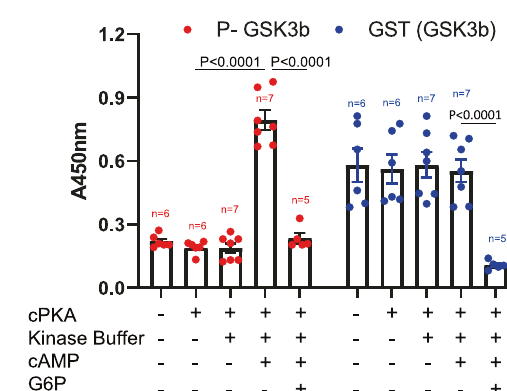
Fig. 4 HK2-GSK3 β -R1a tertiary complex binds PKA catalytic subunit and promotes GSK3 β phosphorylation. a Nickel-coated plates were incubated overnight at 4 °C with His-HK2 (50 nM) and then successively incubated with Myc-PRKAR1 α (32 nM), PKAc (20 nM), and GST-GSK3 β (32 nM). For the negative control experiments, His-HK2 or Myc-PRKAR1 α were omitted. Once all proteins are bound, antibodies against HK2, PRKAR1 α , PKAc, or GSK3 β are added for overnight incubation and detection is carried out after incubation with HRP-conjugated anti-rabbit or mouse IgG as described in Methods. Results are the mean ± SEM of four independent experiments. b Nickel-coated plates were incubated overnight at 4 °C with His-HK2 (50 nM) and then successively incubated with Myc-PRKAR1 α (32 nM), PKAc (20 nM) and GST-GSK3 β (32 nM). Kinase buffer in the presence or absence of cAMP is added to appropriate wells and P-GSK3 β antibody is added overnight, and then detected by incubation with HRP-conjugated anti-rabbit IgG. Bound total GSK3 β is detected with anti-GST-HRP-conjugated antibody. Both detections were revealed by HRP-catalyzed reaction with a chromogenic substrate solution. For G6P inhibition, G6P was added 30 min before the end of the incubation with GST-GSK3 β . Results are the mean ± SEM of fi ve independent experiments as depicted by n for each column. One-way ANOVA was used to calculate signi fi cance. Source data are provided as Source Data fi (Fig. 7a, Supplementary Fig. 13a, b, and Supplementary Data 1). Interestingly, when we had a close look at two adjacent clusters; cluster 14, which expresses the highest levels of epithelial markers, and cluster 15, which expresses the highest levels of mesenchymal markers, we found changes in the expression of SNAIL target genes by the deletion of HK2 (Supplementary Fig. 13c). Cluster 14 exhibited high expression of the epithelial markers including